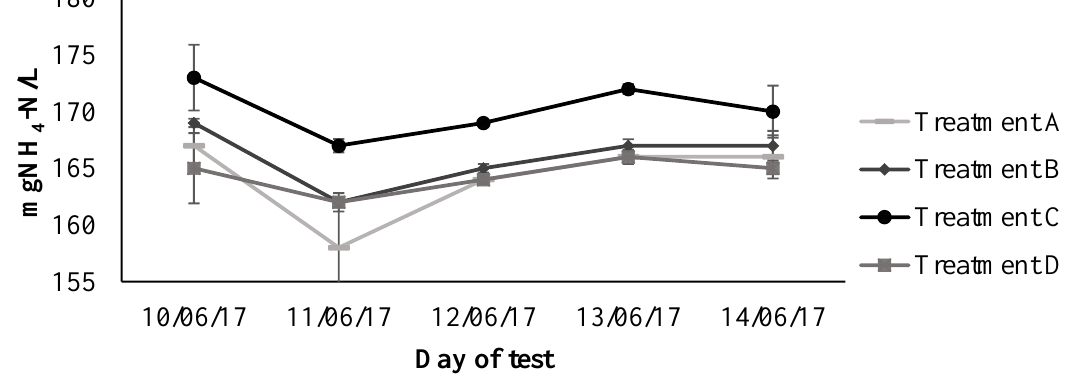
Figure 2. The mean of NH 4 + -N concentrations (mgNH 4 + -N / L) recorded during the ammonium volatilisation test. Treatment A (constant aeration), Treatment B (intermittent aeration 4h AA:4h no-AA), Treatment C (intermittent aeration 6h AA:4h no-AA), Treatment D (no aeration), AA = aeration.